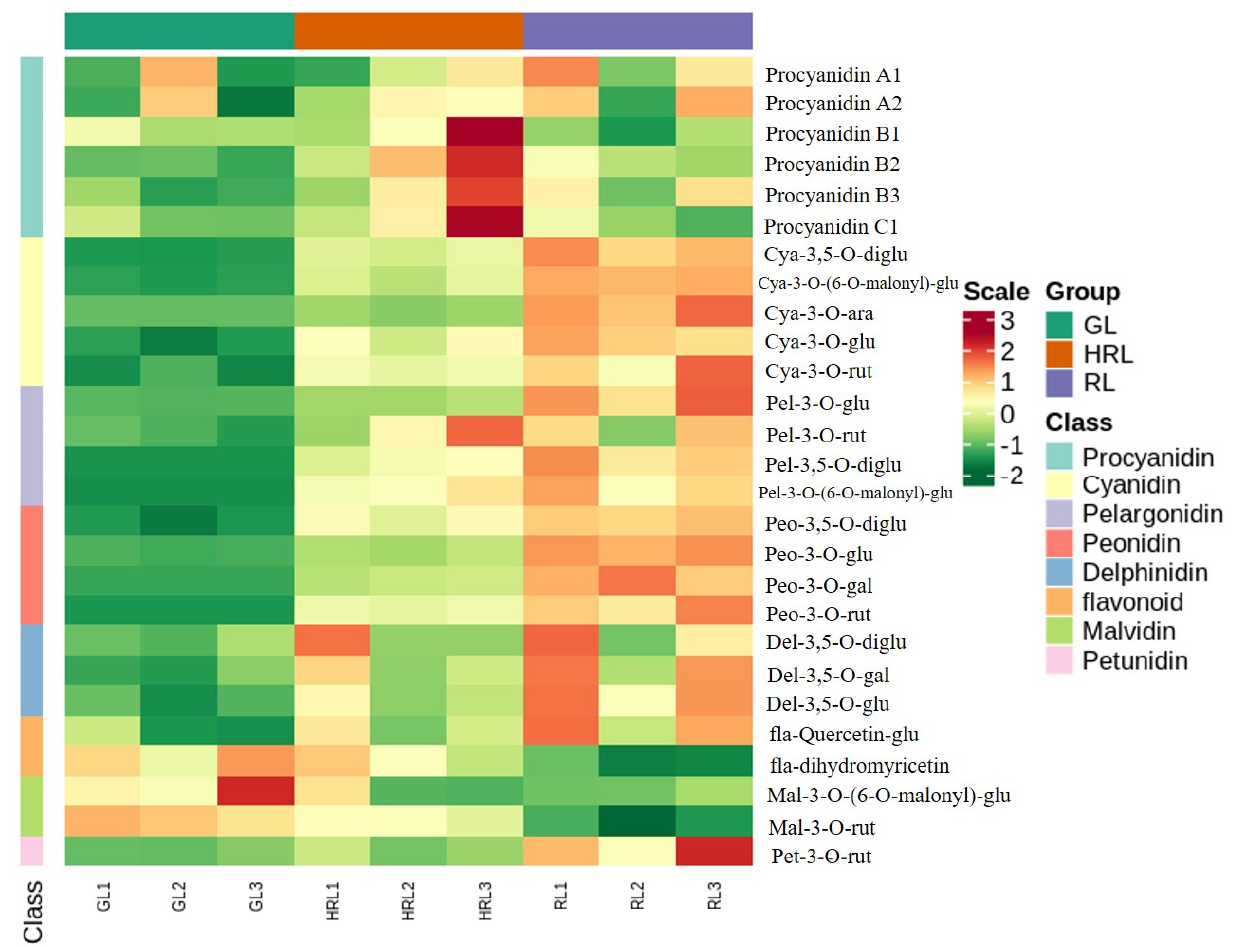
Figure 2. Heatmap of the identified metabolites in green (GL), orange (HRL), and red (RL) leaves. The color scale indicates the normalized metabolite contents using Row Z ‐ score. The name of each anthocyanin compound is listed on the right side of the heatmap.